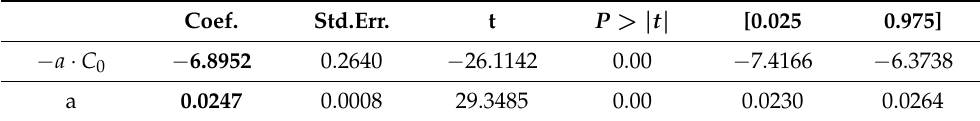
Table 1. The result table of the Python linear regression model displays, for each regression variable, its estimated value (“Coef.”), its estimated standard error, the t-statistic for the variable being non- zero, and the error probability under the null hypothesis that the variable is non-zero. The last two columns show the error bounds, i.e., the 95% inter0val of the variable’s value. Coef. Std.Err. t P > | t | [0.025 0.975] − a · C − 0